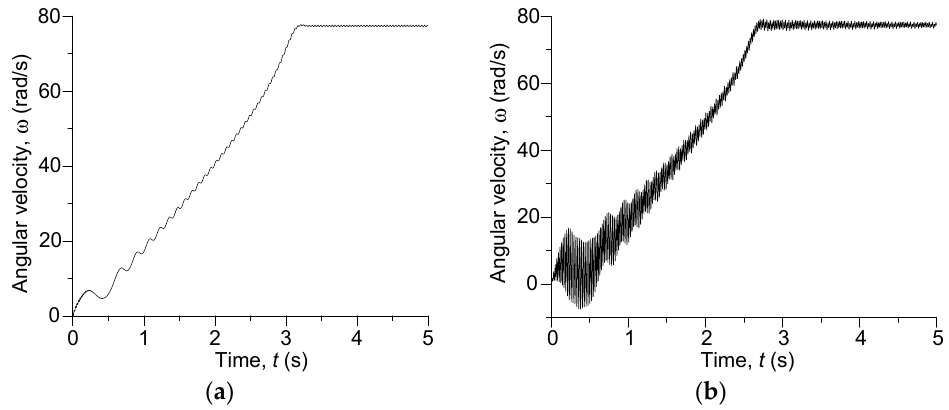
Figure 10. Angular velocity of motor rotor versus time for α 1,2 = α 2,3 = π /5 and shaft diameter: ( a ) D